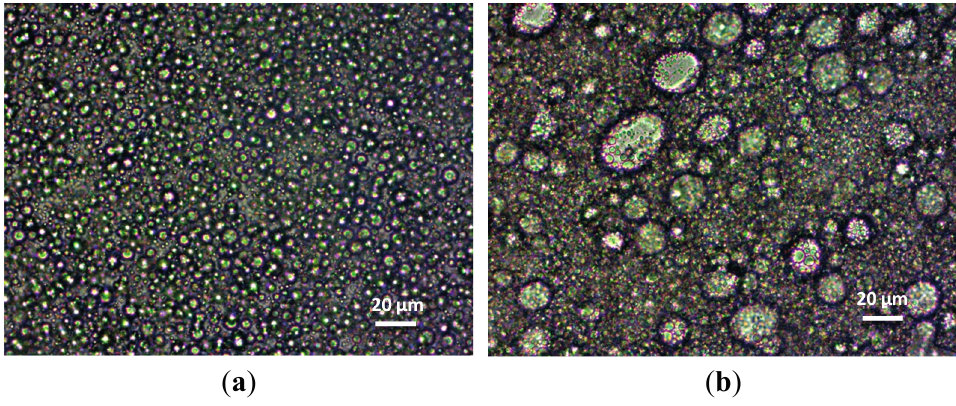
Figure 4. Viscosity of O/W basic emulsions (E2, E4–E7) containing different amounts of oil phase.